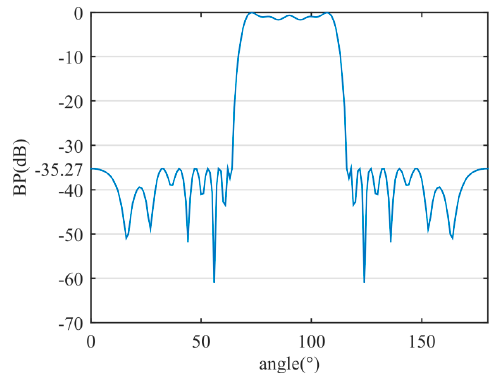
Table 2. Comparisons of flat-top BP synthesis results among the proposed method and the existing methods.